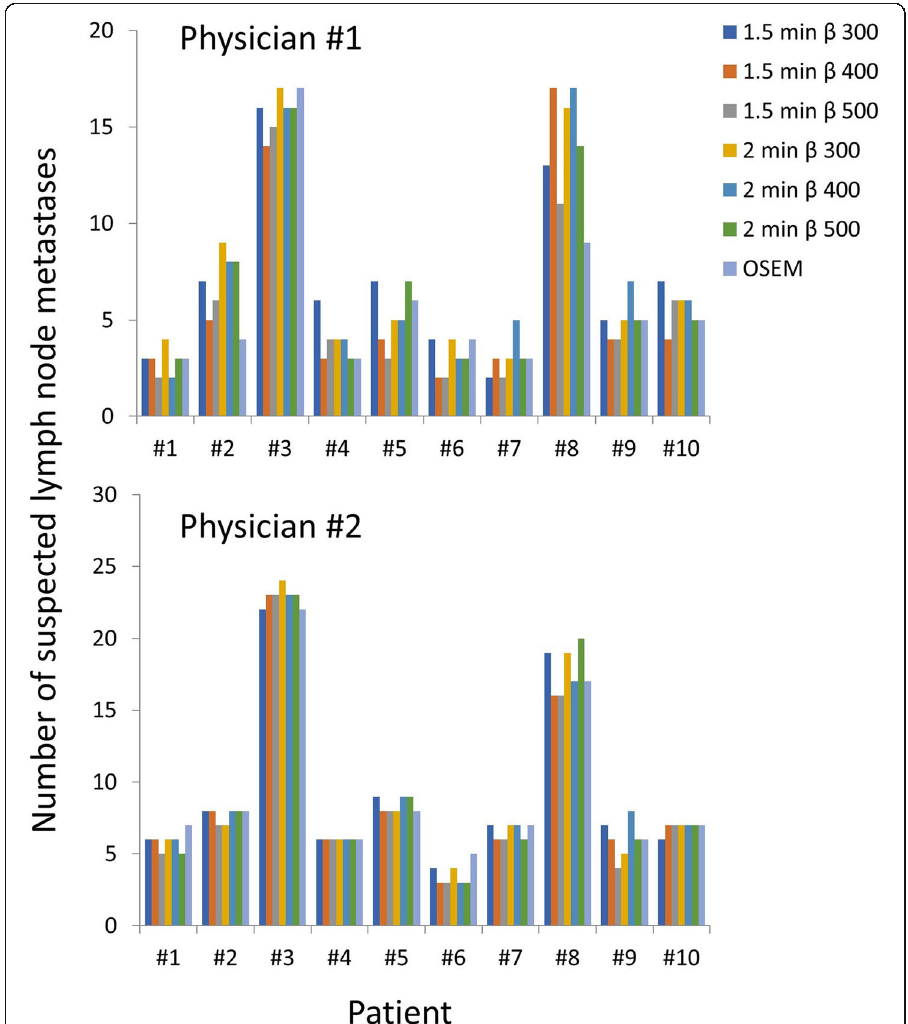
Fig. 6 Number of suspected metastatic lymph nodes for different image series. The graphs show the number of lymph nodes detected for the two nuclear medicine physicians (upper and lower graph) for the ten patients. The only significant difference was between 1.5 min with β 500 and 2.0 min with β 300 for physician